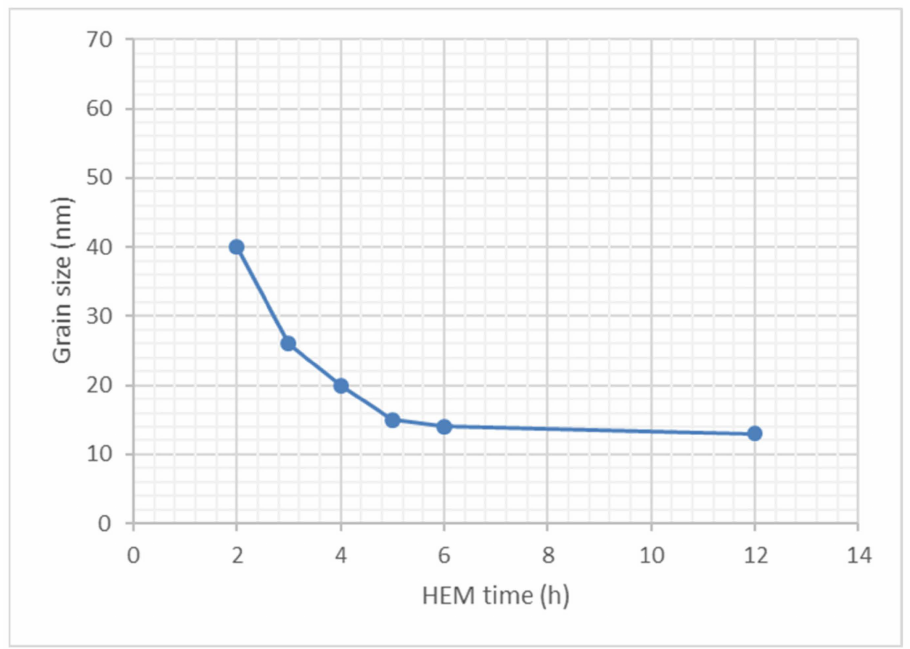
Figure 3. Grain size as a function of high-energy milling time. There was a rapid decrease in the size before the 5-h milling, reaching close to the saturation value of the size reduction.